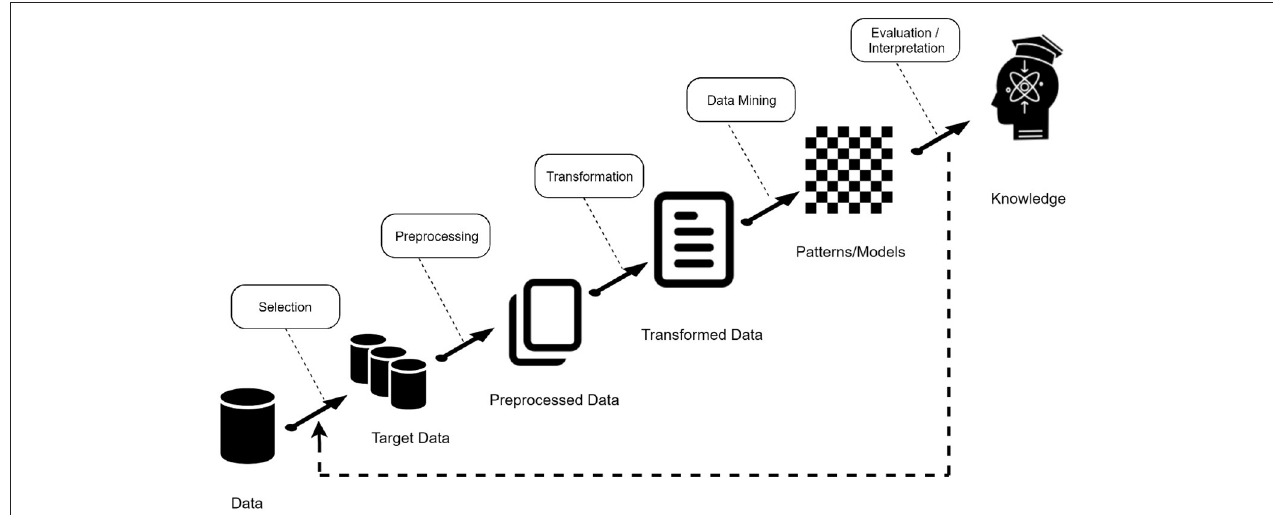
FIGURE 1 | Steps in the data analysis